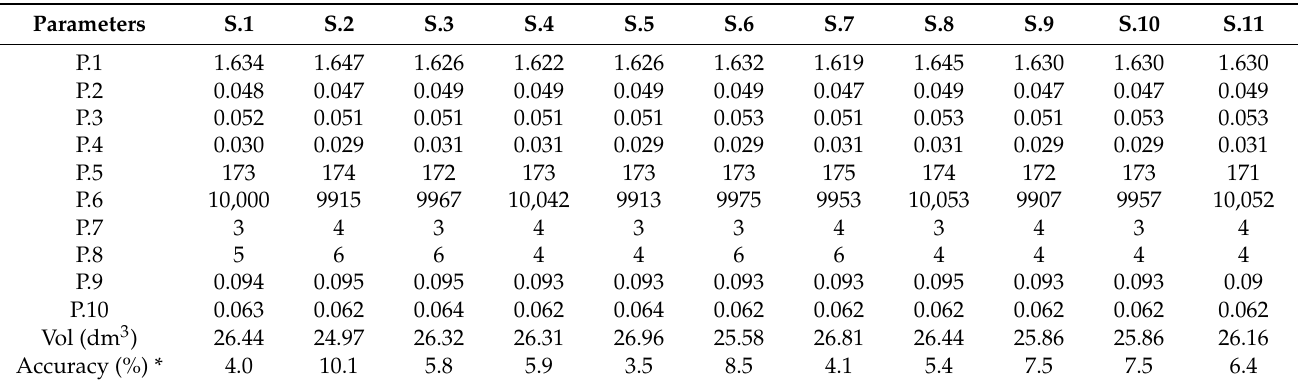
Table 2. A simulation of human influence in the stem volume estimation using Simpletree. S.1 refers to a first tree model made by a staff without prior knowledge of ground truth; S.2 to S.11 refers to the simulated model results made by another ten persons; P.1 to P.10 refers to parameters used in the “choose thresholds” UI in Simpletree [32]; they are all mathematical values without physical unit; Vol(l) refers to the stem volume, the unit is dm 3